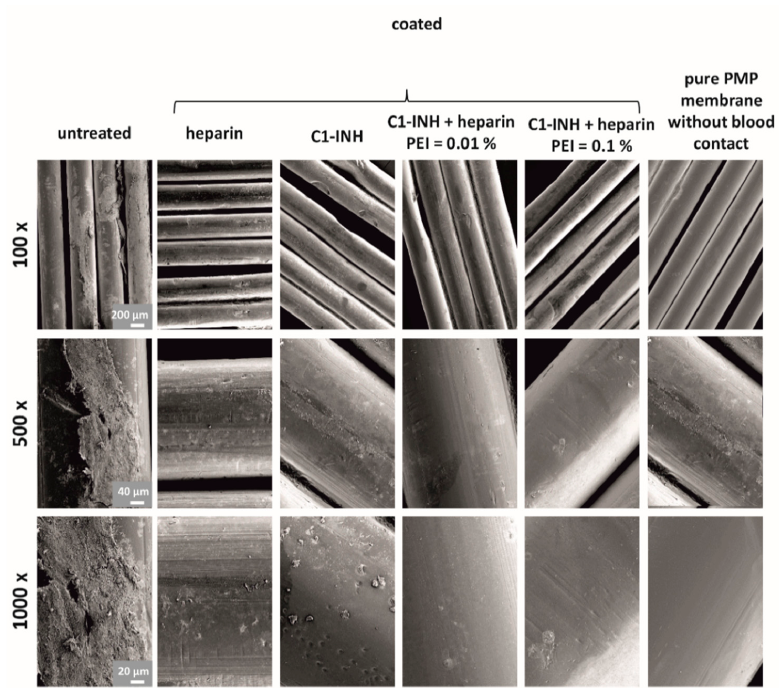
Figure 7. SEM images show an obvious decrease in platelet aggregation and fibrin formation. This